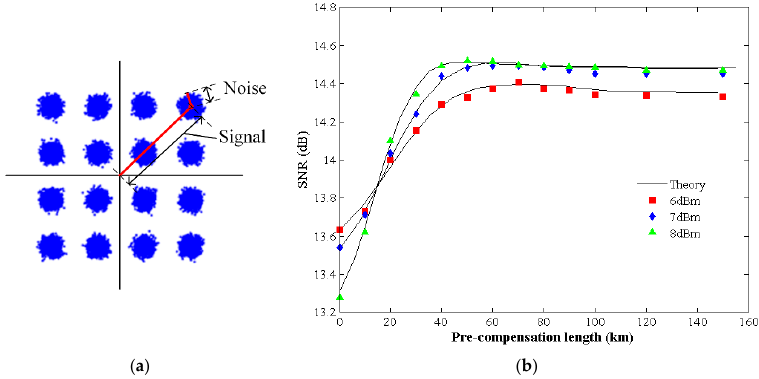
Figure 4. ( a ) The calculation method of the error vector magnitude (EVM) of the signal, ( b ) signal-to- noise ratio (SNR) vs. the pre-compensation length.